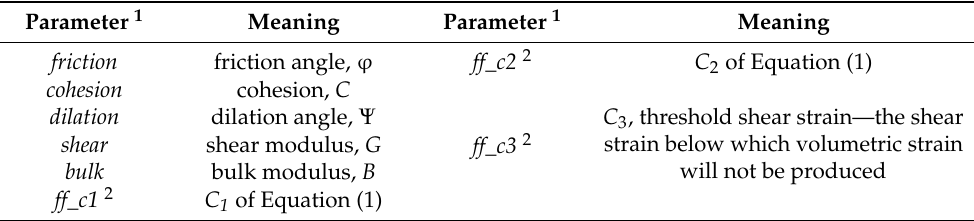
Table 1. Input parameters of the Finn model with Byrne formulation in FLAC. Meaning Parameter 1 Meaning ff_c2 2 C 2 of Equation (1) C 3 , threshold shear strain—the shear strain below which volumetric strain ff_c3 2 will not be produced